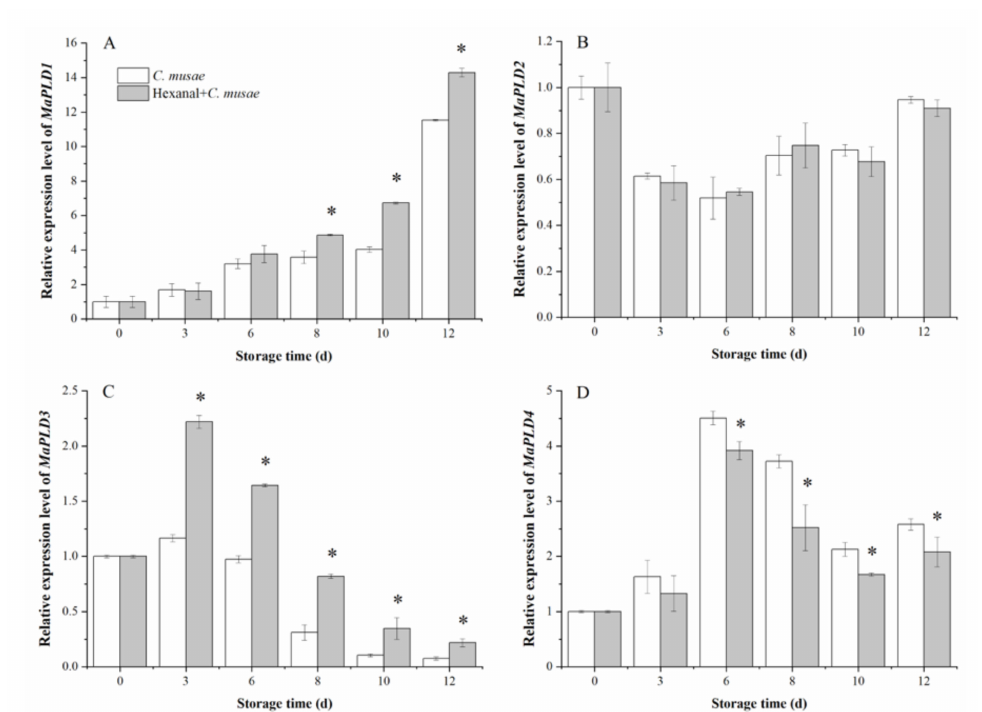
Figure 4. Effect of hexanal treatment on expression of MaPLD1 ( A ), MaPLD2 ( B ), MaPLD3 ( C ), and MaPLD4 ( D ) genes in banana fruits under the infection of C. musae . The experiment was performed in triplicate. Asterisks indicated that values are significantly different between hexanal-treated and C. musae -treated fruits at the same time point using LSD test (* p <